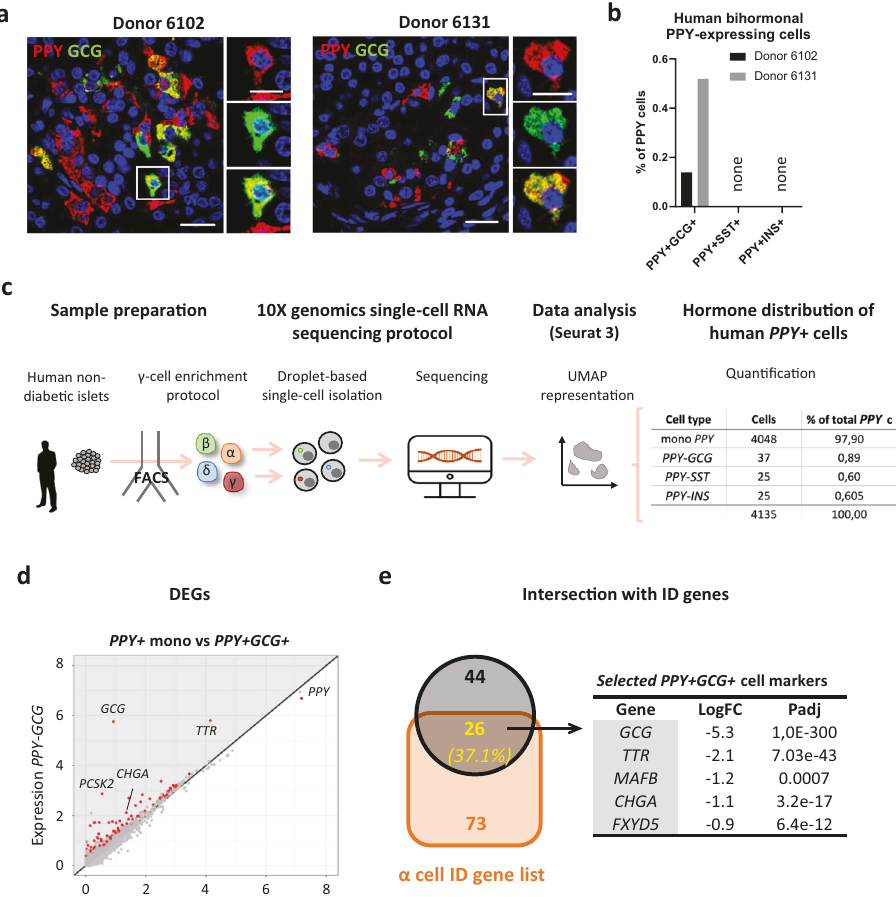
Fig. 6 Human islets contain bihormonal cells co-expressing PPY and another hormone. a Bihormonal PPY + GCG + cells could be detected by immuno fl uorescence (insulin, red; glucagon, green) in human islets from two donors. Scale bar: 20 μ m (islet) or 10 μ m (cell). b Quanti fi cation of bihormonal PPY + cells in human islet sections ( n = 2 human donors; in donor 6102, 2 PPY + GCG + were detected in 1395 PPY + cells; in donor 6131, 6 PPY + GCG + cells were detected in 1154 PPY + cells). c Experimental protocol and analysis of human islets single-cell RNA-sequencing data. The experiment was performed once with islets from three independent donors ( n = 3 human donors). 4135 PPY -expressing cells were obtained after the analysis. Among them, bihormonal PPY -expressing cells could be detected at transcriptomic level: 37 PPY + GCG + cells, 25 PPY + SST + cells and 25 PPY + INS + cells. d Expression plot of differentially expressed genes (DEGs) in bihormonal PPY + GCG + relative to monohormonal PPY -expressing cells. Each dot represents one gene. Red dots represent the genes with P value < 0.05. Gene names label the top DEGs. Gray area indicates the upregulated genes in the bihormonal population. Differential expression was calculated using a negative binomial generalized linear model in a pairwise manner between populations, taking along the number of UMIs and the number of genes as variables to regress. P values (in panel e and Source Data s) are Bonferroni corrected based on the total number of genes in each dataset. e Intersection of the upregulated genes in PPY + GCG + from d , with human α -cell ID gene list. 26 out of 70 PPY + GCG + -enriched genes were identi fi ed as important markers for adult α -cells. Source data are provided as Source Data fi le (Supplementary Tables n, r,